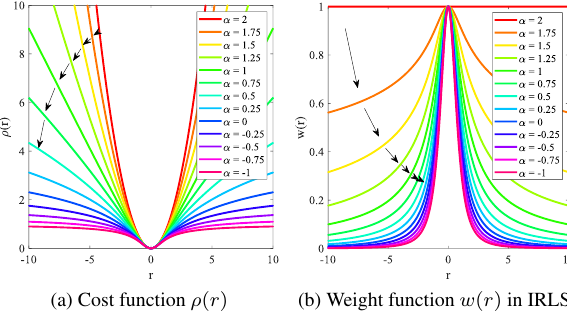
Figure 1. Comparisons between non-robust least-squares cost and robust M-estimation costs ( r is the residual of an observa- tion).